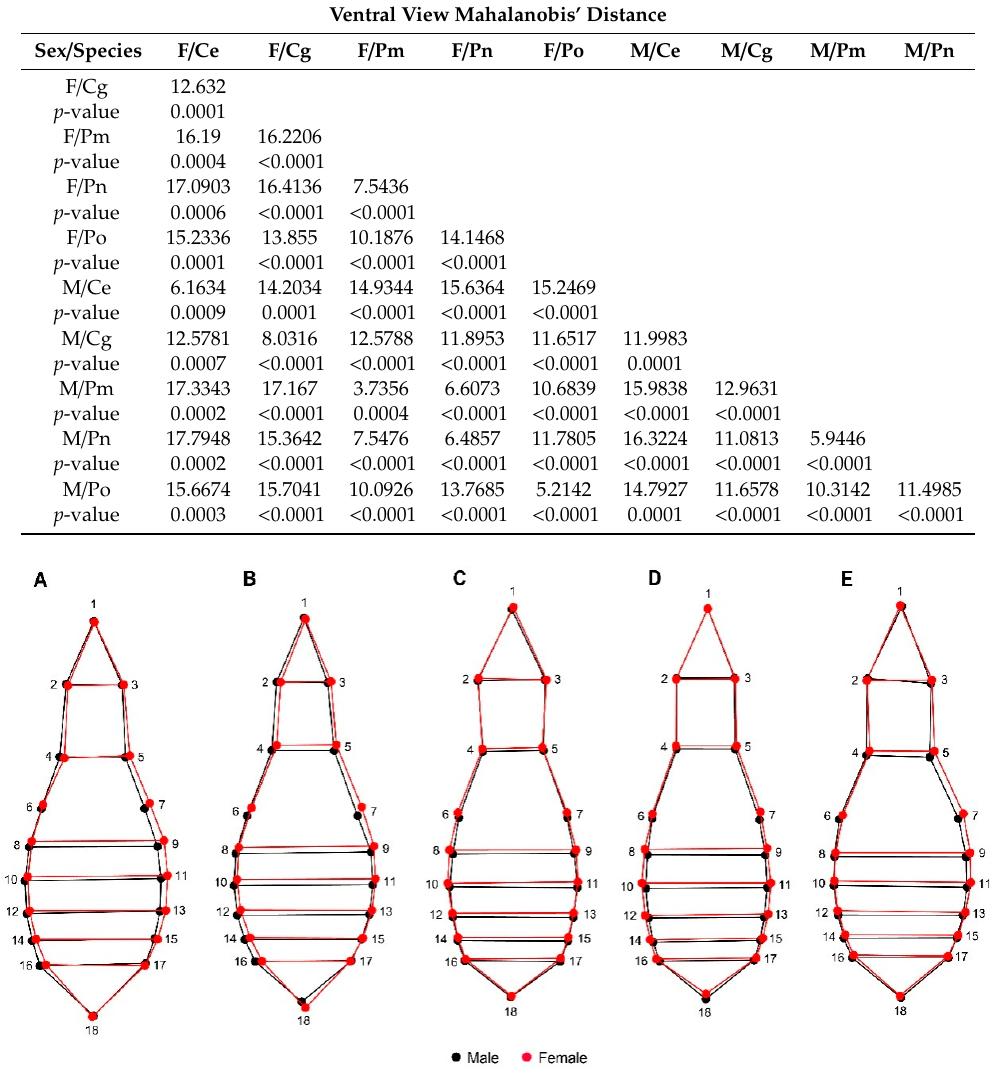
Table 3. Mahalanobis distances and the respective p -values of the pairwise permutation for the ventral view in the comparison of sexual shape dimorphism using sex and species as a combined classifier. Ventral View Mahalanobis’ Distance